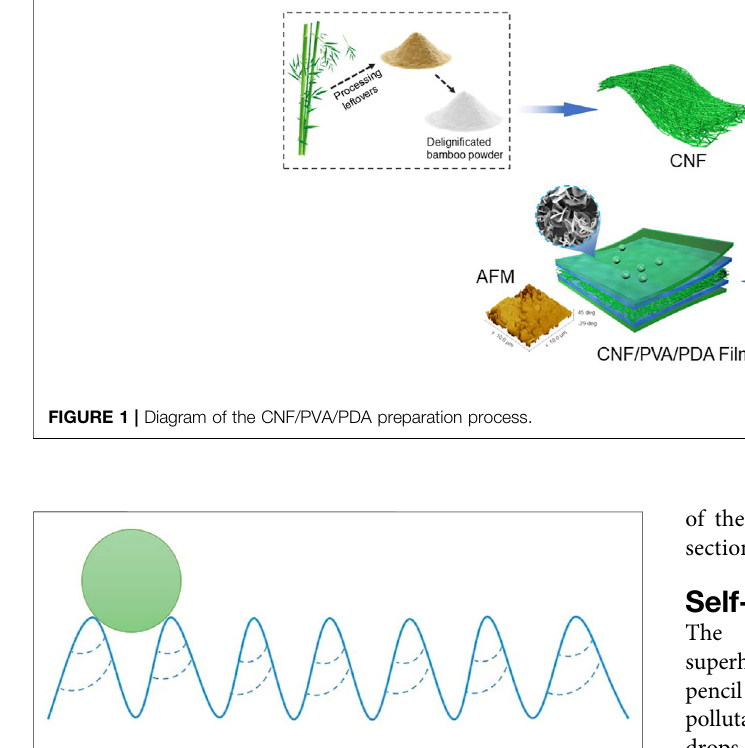
FIGURE 2 | The mechanism of droplet formation on CNF/PVA/PDA fi lm